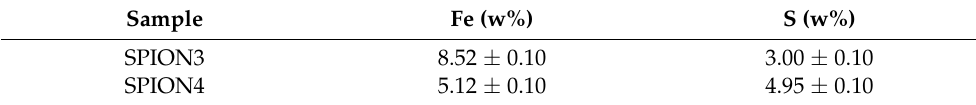
Table 2. ICP-OES Fe and S w% results for SPION3 and